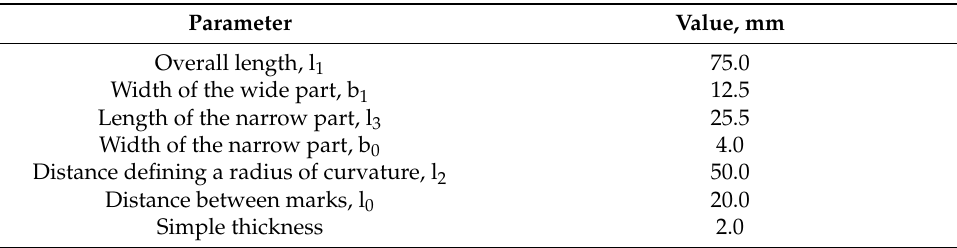
Table 2. Dimensions of the samples for research.